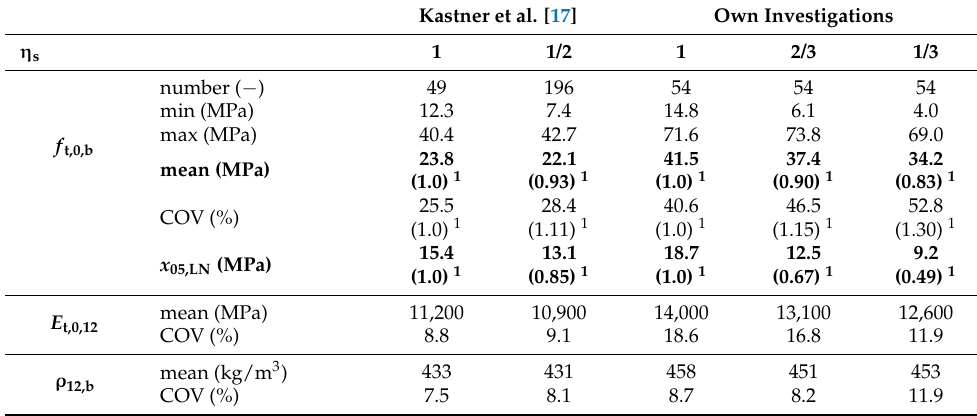
Table 9. Results from the tensile tests parallel to the grain on boards for different separation ratios; data taken from Kastner et al. [17] and own investigations (see Scherfler [33] for further